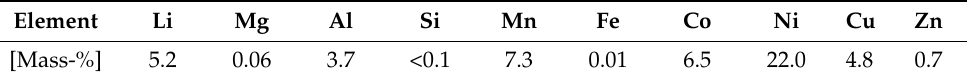
Table 1. Composition of the pyrolyzed active material from lithium-ion batteries used for leaching experiments (determined by ICP-MS: mass spectrometry with inductively coupled plasma). Element